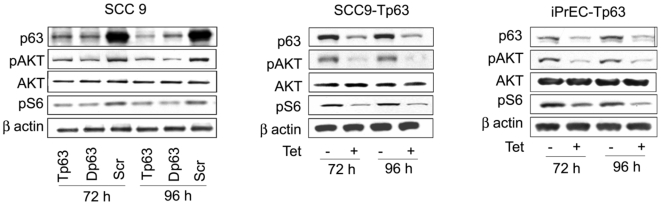
p63 silencing induces a decrease in AKT phosphorylation.Immunoblot analysis of total AKT, phospho-AKT (Ser 473), and phospho-S6 (Ser 235/236) in SCC9 cells transfected with Tp63, Dp63 or Scr siRNAs (left panel), in SCC9-Tp63 cells with or without treatment with tetracycline (middle panel) and in iPrEC-Tp63 cells with or without treatment with tetracycline (right panel).